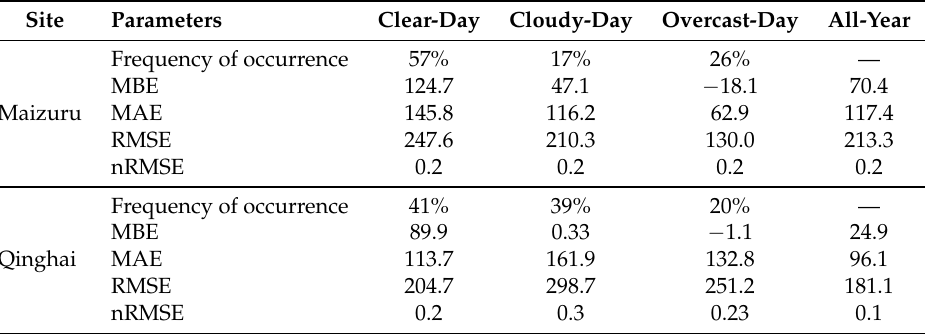
Table 2. Performance statistics of hourly WRF (Weather Research and Forecasting) raw forecasts of solar radiation (W/m 2 ) under different sky conditions from 1 January to 31 December 2018 for the Maizuru site, and from 1 January to 31 December 2017 for the Qinghai site, respectively. Site Parameters Clear-Day Cloudy-Day